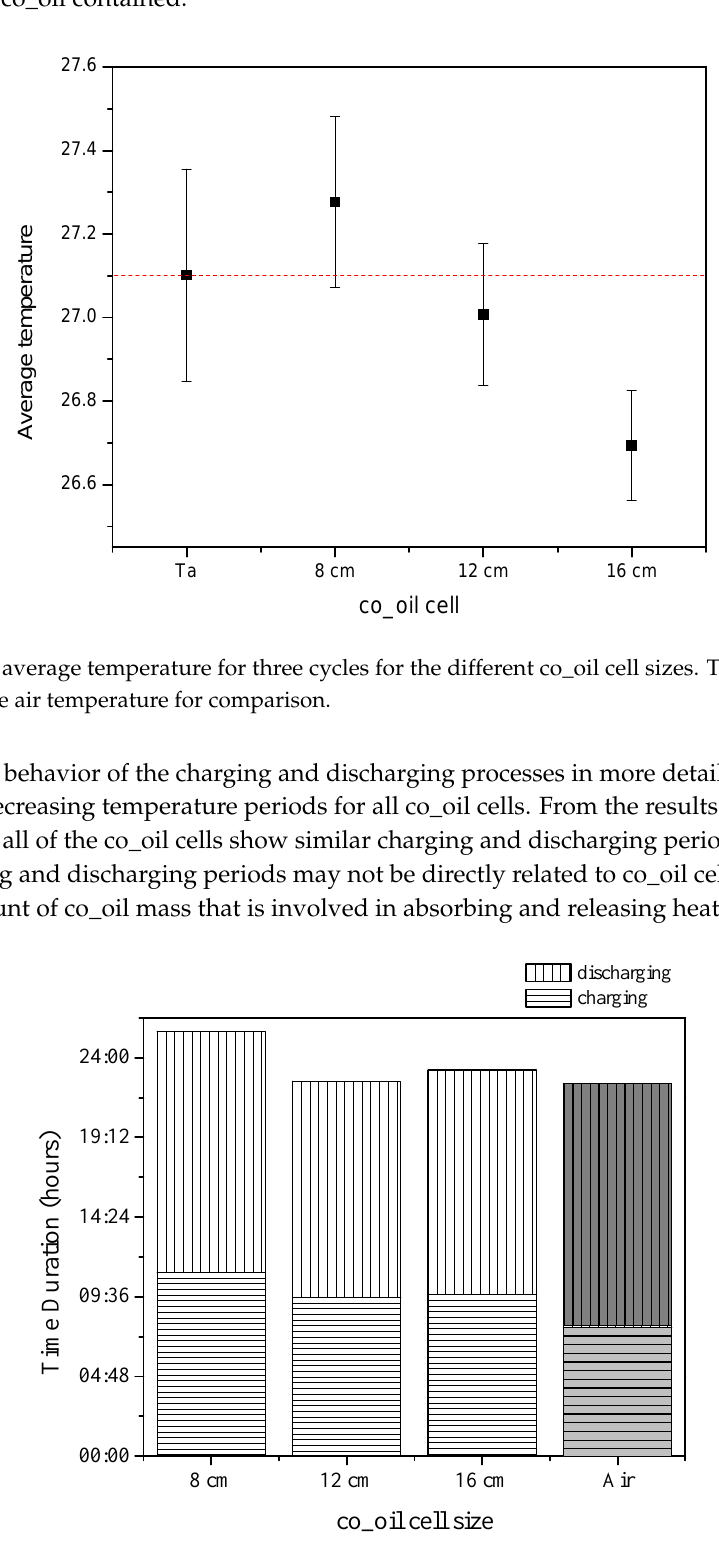
Figure 9. The column chart for average charging-discharging periods of co_oil cells of 8, 12, and 16 cm, compared to heating and cooling periods of air temperature.